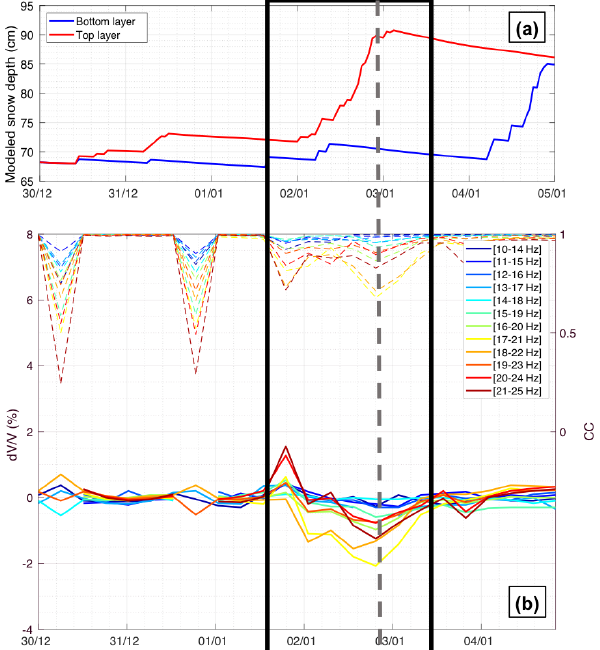
Figure 6. Observations during snowfall event 1 (SF1), with the modeled depth of each snow layer from SNOWPACK simulations (a) , and d V/V measurements at different frequency bands, with corresponding CC values in dashed lines (b) . When the correlation coefficient (CC) is too low (CC < 0 . 6), d V/V values are considered outliers and then removed. The frame in black shows approximately the whole period of interest, whereas the dashed grey line highlights precisely the state of the medium with corresponding observables, just after the event.